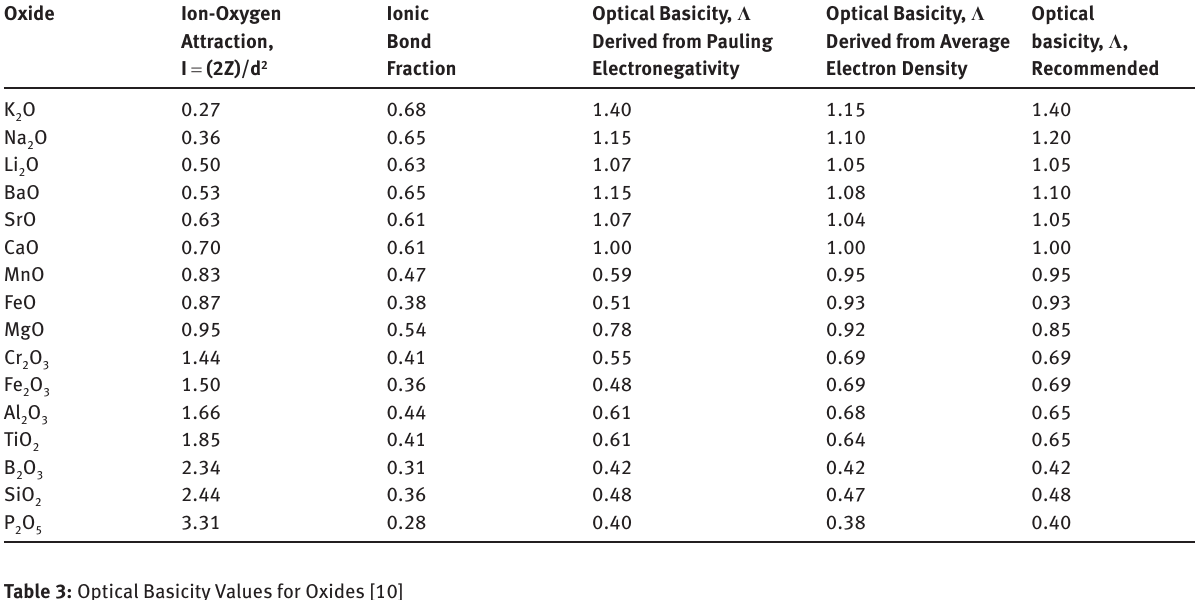
Table 3: Optical Basicity Values for Oxides [10]